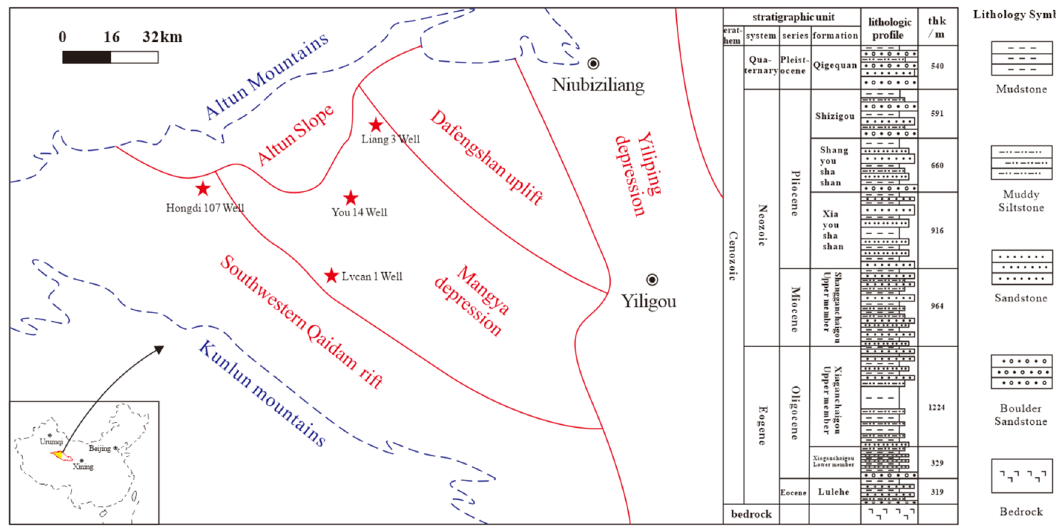
Fig. 1 Location of Western Qaidam Basin and characteristics of stratigraphic